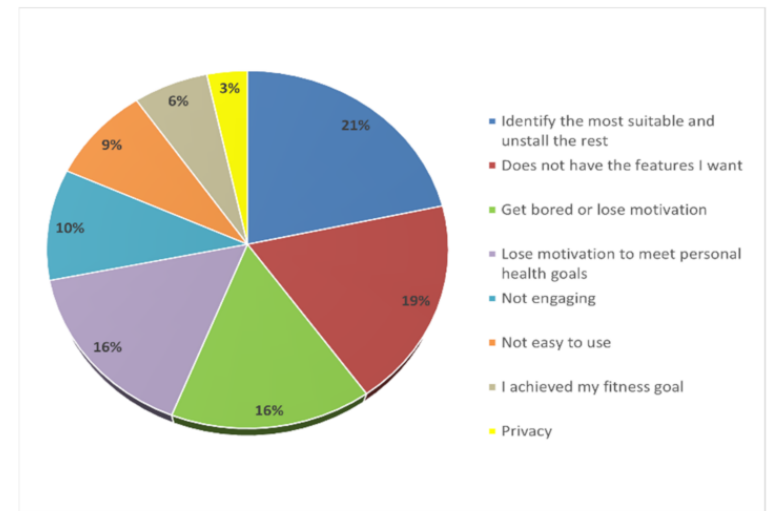
Figure 4. Main reasons for app abandonment by users.